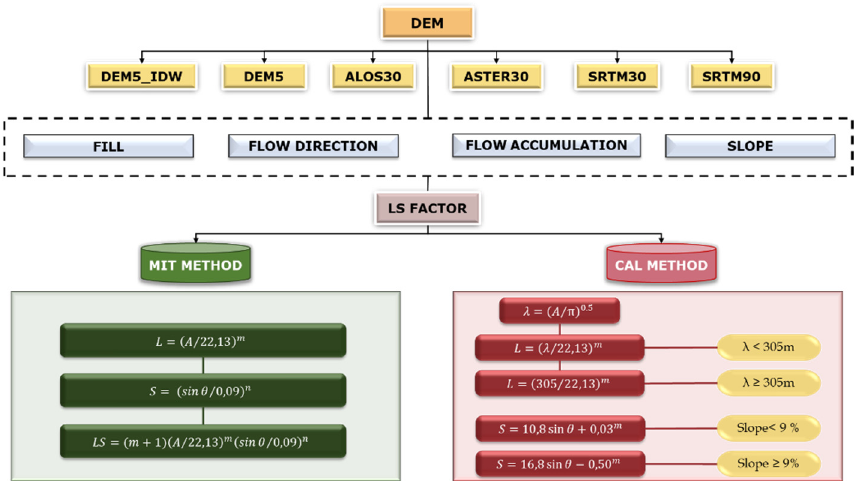
Figure 6. A flowchart of the proposed methodology for the calculation of the topographic factor LS.